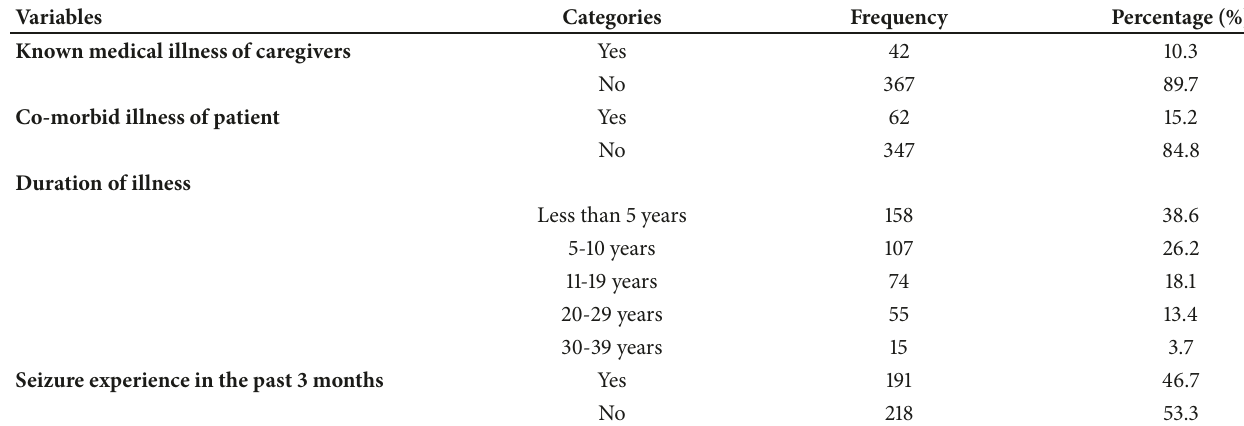
Table 2: Clinical Characteristics as reported by caregivers of patients with epilepsy, Amanuel Mental Specialized Hospital, Addis Ababa, Ethiopia, 2017 (n=409).